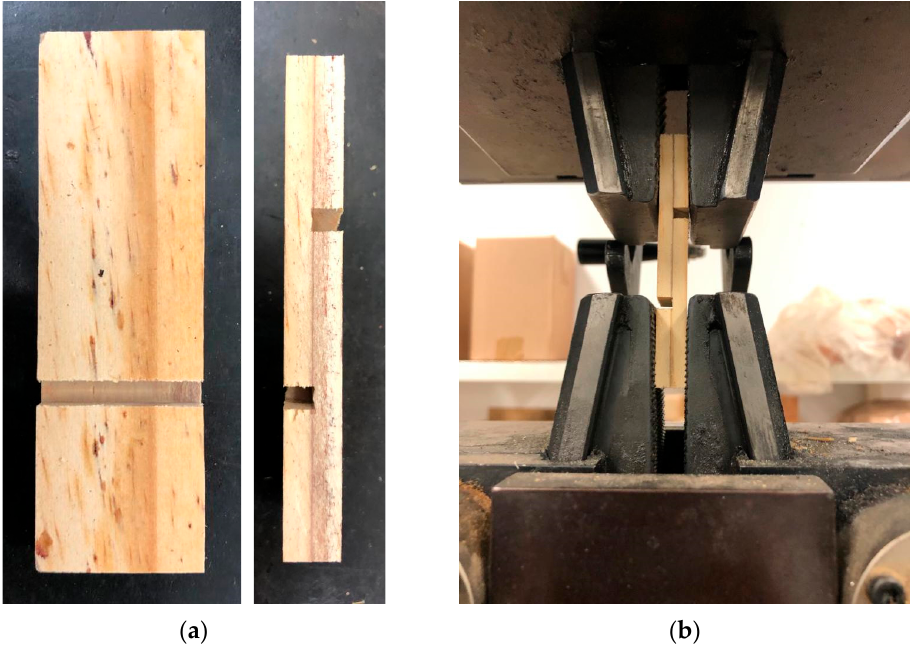
Figure 1. Shear strength test in the glue line: ( a ) specimens, and ( b ) test in operation.